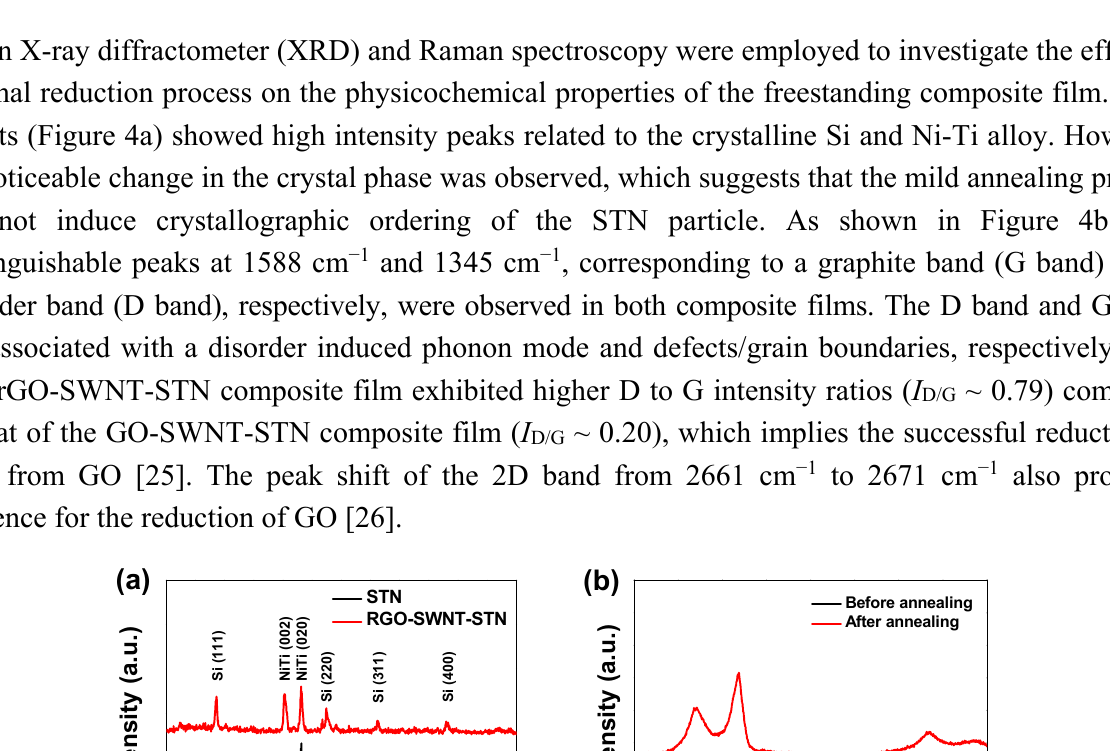
Figure 3. ( a ) SEM and ( b ) transmission electron microscope (TEM) images of rGO-SWNT-STN composite film.